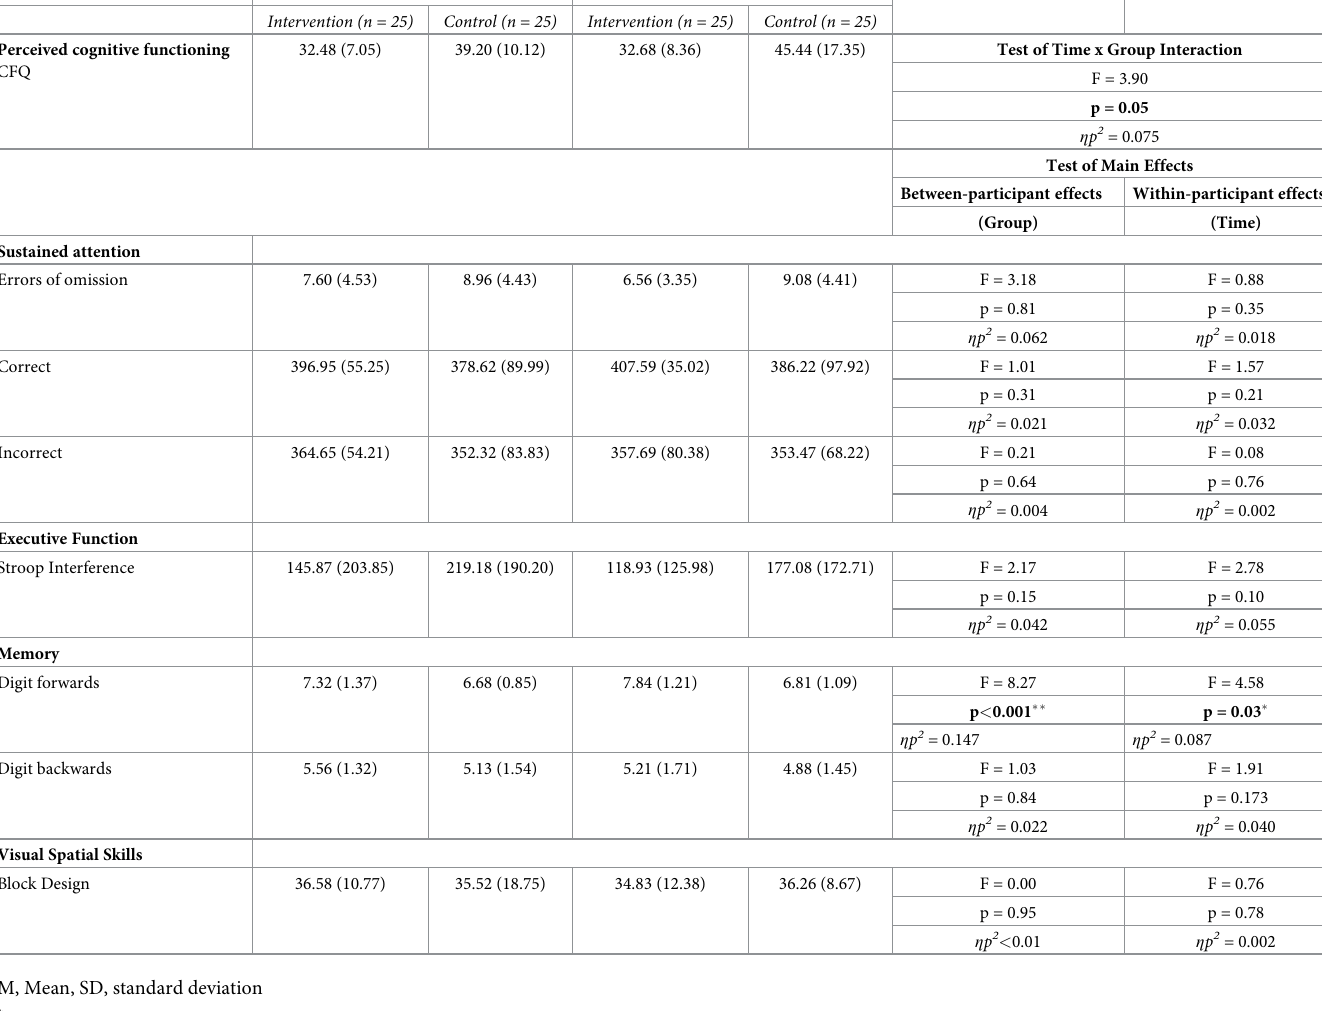
Table 2. Mixed model ANOVAs to test the difference between the two groups (intervention and control) and difference within each group (pre and post) on out- come measures of cognitive function. Variable Pre-intervention Post-intervention Intervention (n = 25) Control (n = 25) Intervention (n = 25) Control (n = 25) Perceived cognitive functioning